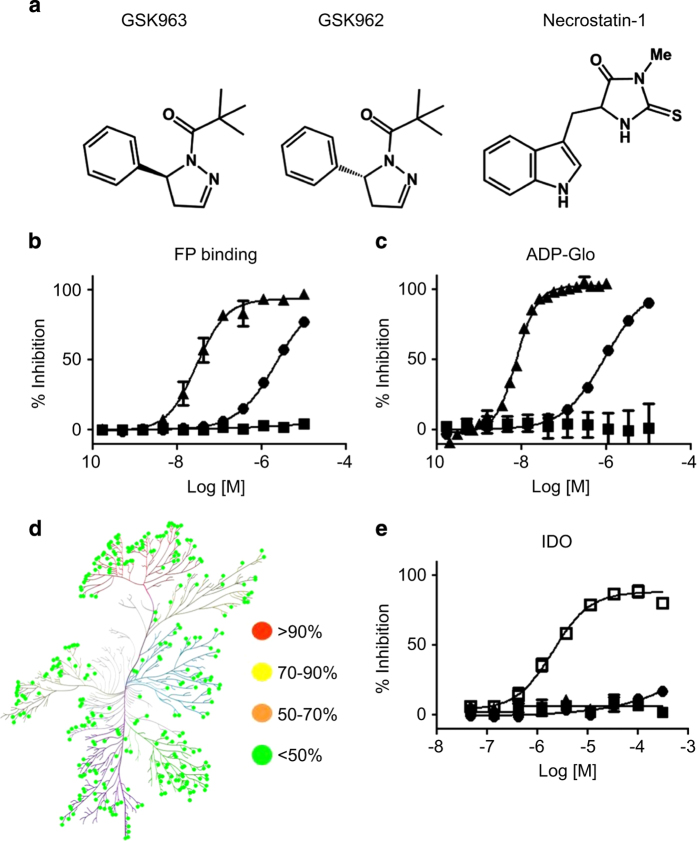
GSK′963A is a potent and selective inhibitor of RIP1 kinase. (a) Chemical structures of GSK′963A (active analog), GSK′962A (inactive analog) and Necrostatin-1. (b) Dose–response curves for GSK′963, GSK′962 and Nec-1 in the FP binding assay evaluating the affinity of compounds for RIP1 (ATP-binding pocket). Graphs represents n=52 for Nec-1, n=4 for GSK′962A and n=7 for GSK′963A. Error bars indicate S.D. (c) Dose–response curves for GSK′963, GSK′962 and Nec-1 in ADP-Glo kinase assay measuring autophosphorylation of RIP1 kinase domain in vitro. Graph represents n=20 for Nec-1, n=2 for GSK′962A and n=2 for GSK′963A. Error bars indicate S.D. (d) GSK′963 does not block the activity of any of the tested 339 human kinases at 10μM concentration, as evaluated at the Reaction Biology Corporation. Each dot represents an individual kinase with the color indicating the level of inhibition (red>90%, yellow 70–90%, orange 50–70% and green <50%) (e) Effect of GSK′963, GSK′962 and Nec-1 on indoleamine 2,3-dioxygenase (IDO) activity evaluated by an in vitro enzymatic assay. Menadione was used as a positive control for IDO inhibition. The results are representative of three independent experiments. =Nec-1, =GSK′962, =GSK′963 and =Menadione.